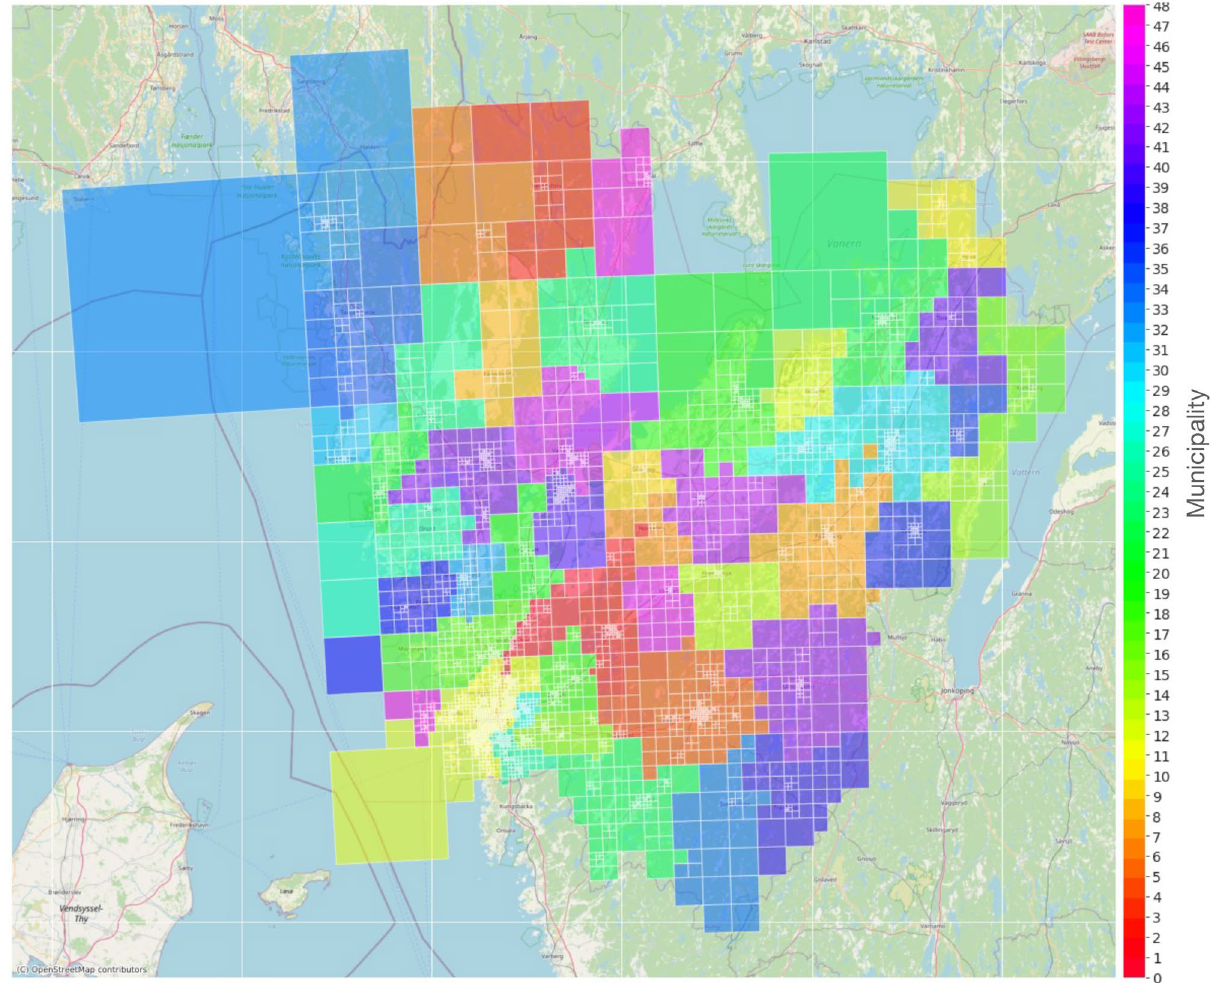
Figure 11. The visualization shows 3720 grids belonging to 49 municipalities located in Västra Götaland county in Sweden provided by Swedish operator Telia Sverige